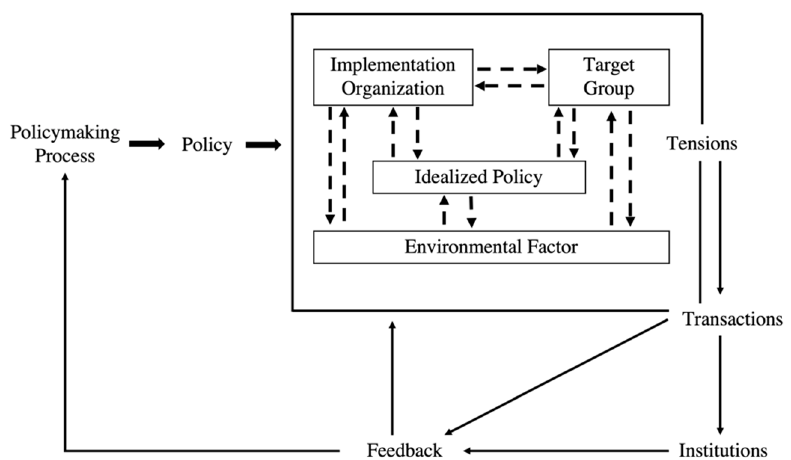
Figure 1. The Smith Policy Implementation Process Model (recreated by authors).